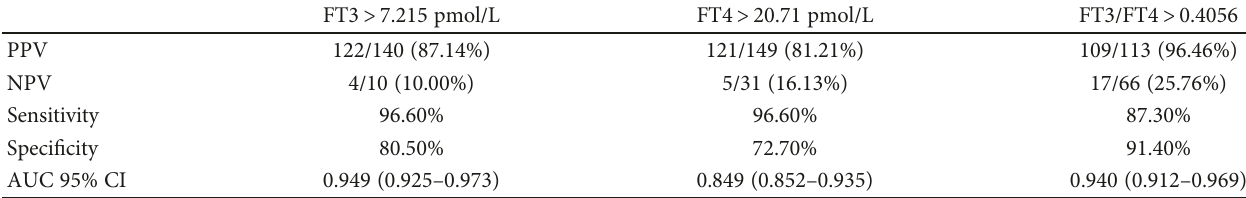
Table 2: Diagnostic evaluation of cut-o ff levels of FT3, FT4, and FT3/FT4 ratio in untreated Graves ’ disease.